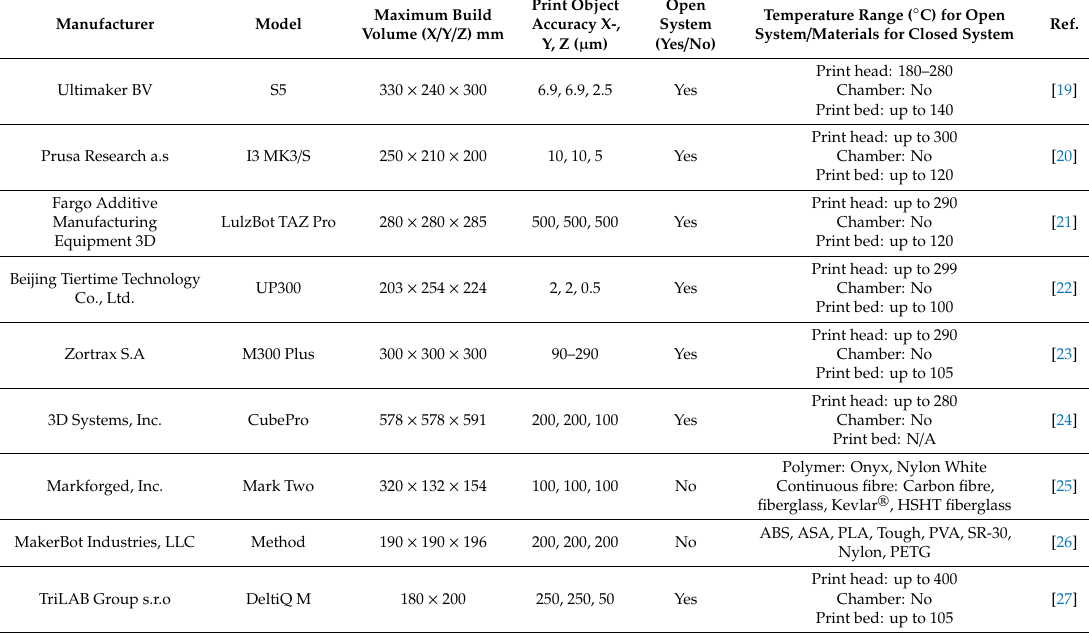
Table 2. Examples of desktop, professional and industrial ME equipment and their